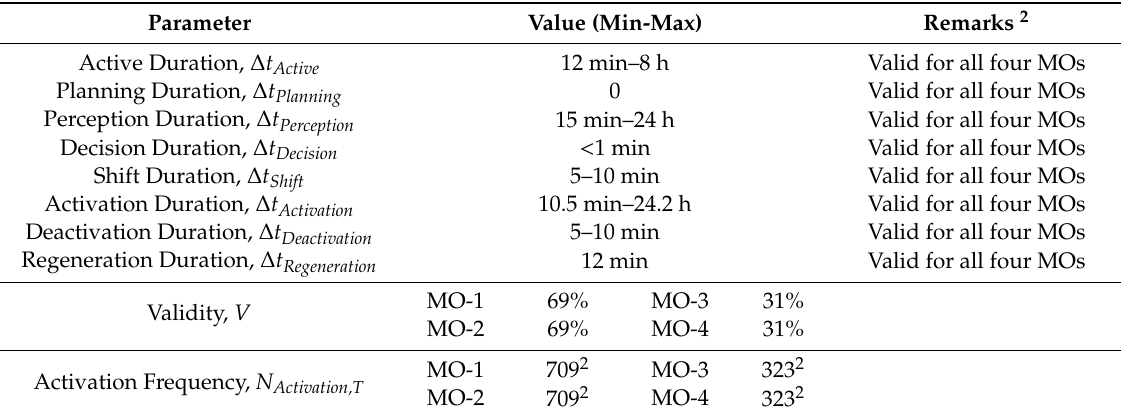
Table 8. Temporal Dimension of the identified EFM 1